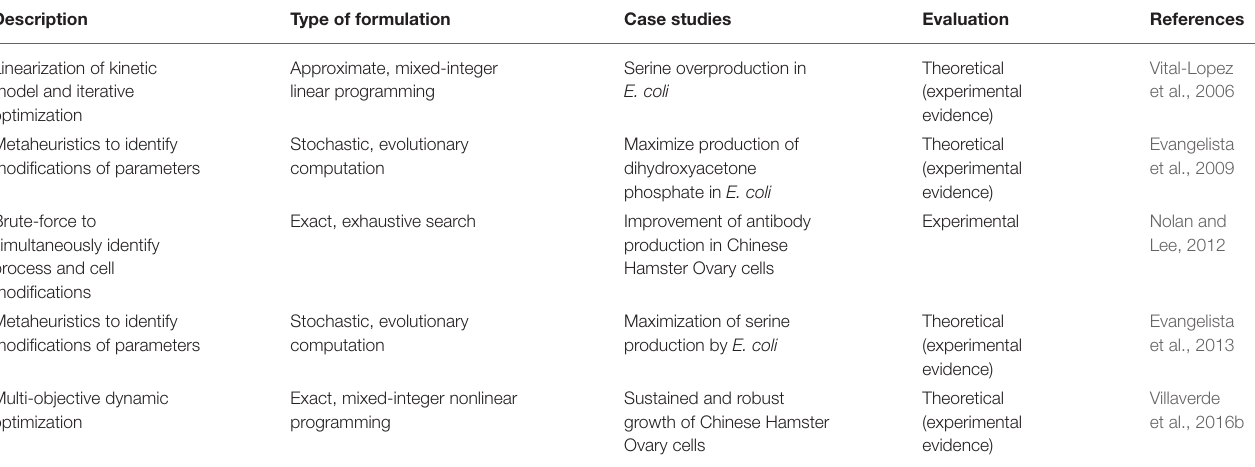
TABLE 2 | Applications of computational strain optimization methods using dynamic